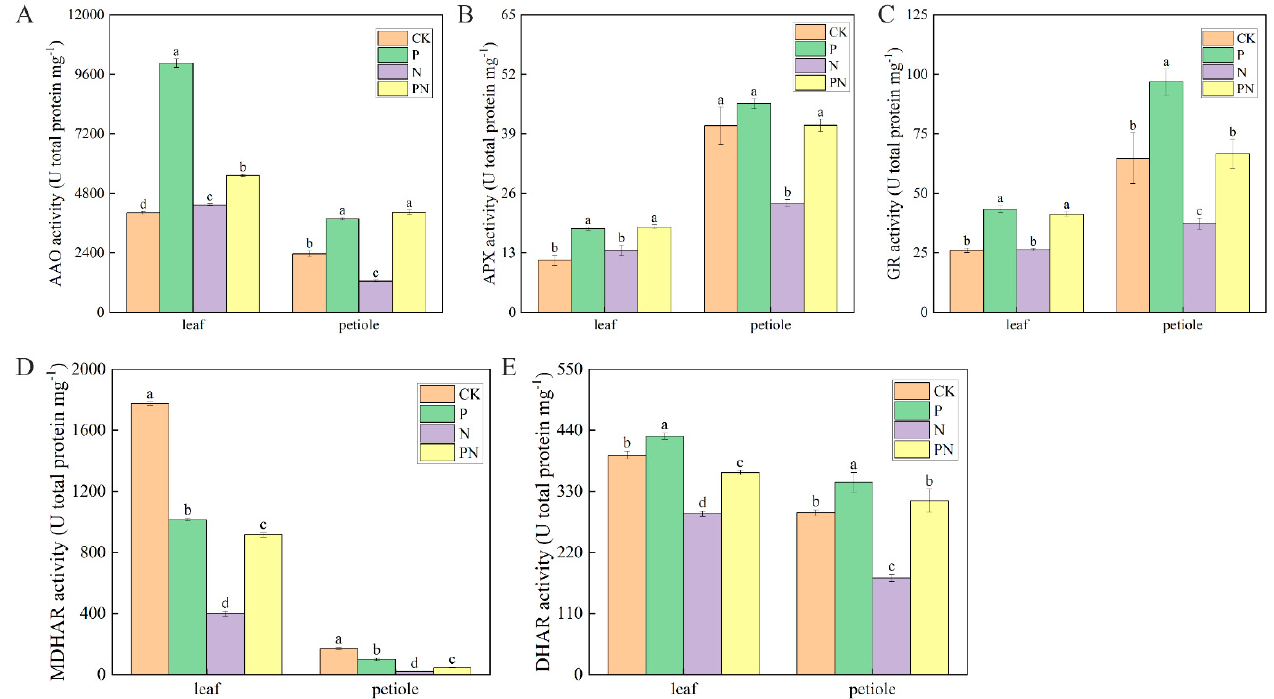
Figure 10. Effect of exogenous proline on the activity of ASA–GSH cycle-related enzymes in celery under salt stress. After planting the 35-day-old seedlings for 7 days, they were treated with 0.3 mM proline solution for 7 days, after which they were watered with 100 mM NaCl solution thrice every 3 days. ( A ) Ascorbate oxidase (AAO) activity. ( B ) Ascorbate peroxidase (APX) activity. ( C ) Glutathione reductase (GR) activity. ( D ) Monodehydroascorbate reductase (MDHAR) activity. ( E ) Dehydroascorbate reductase (DHAR) activity. The results are expressed as the mean ± SE of three replicates, and the different letters denote the significant difference among treatments ( p < 0.05), according to Duncan’s multiple tests. CK, control. P, 0.3 mM proline. N, 100 mM NaCl. PN, 100 mM NaCl+ 0.3 mM proline.